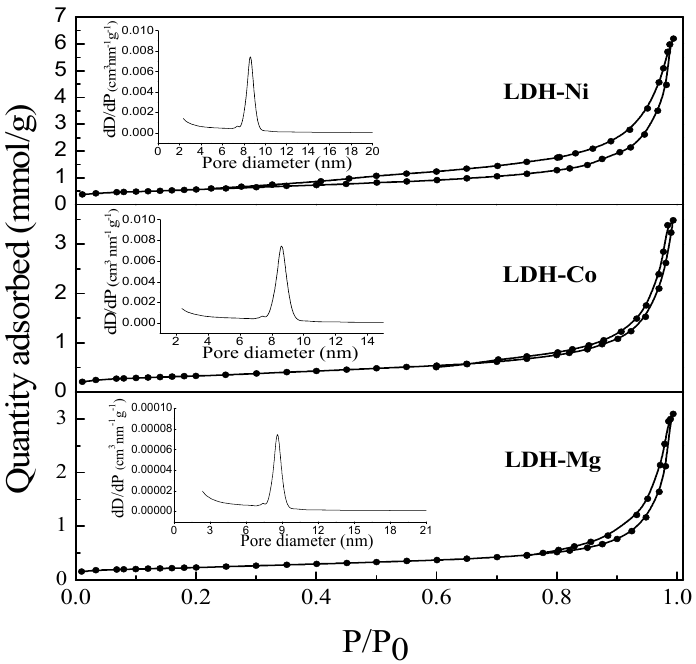
Figure 2. Adsorption–desorption isotherms at 77 K and pore size distribution of synthesized LDH.